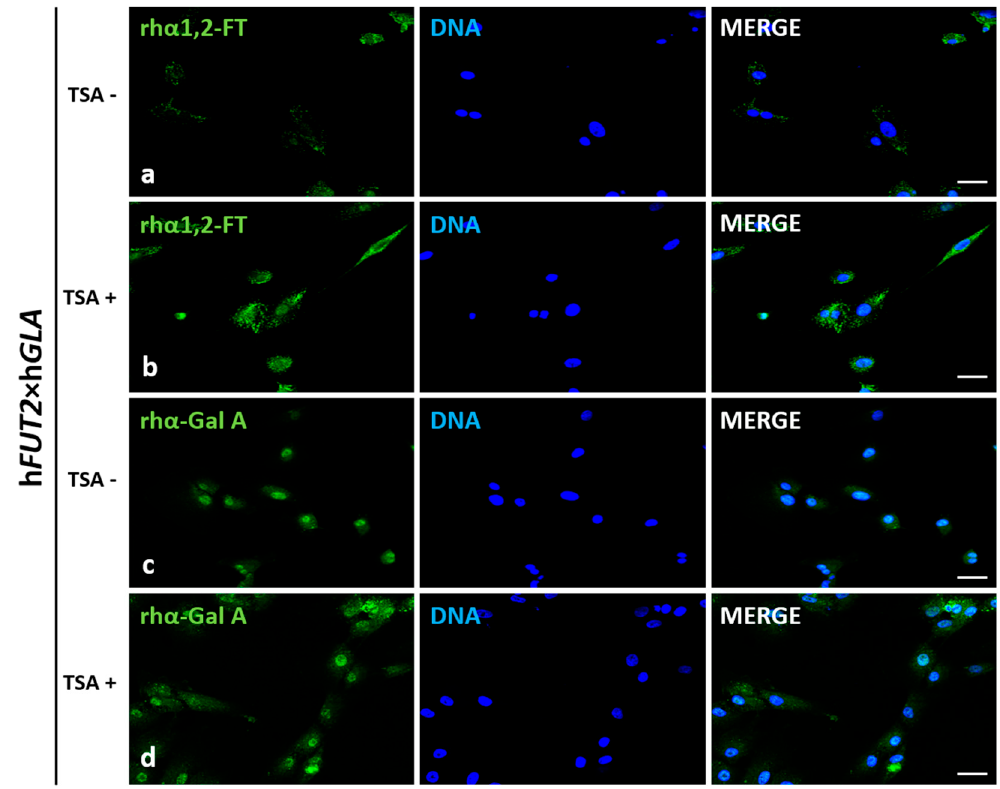
Figure 2. Immunofluorescence analysis of in vitro-cultured porcine ACFCs treated (TSA + ) ( b , d ) and not treated with trichostatin A (TSA − ) ( a , c ). Representative microphotographs of immunofluorescence localization of recombinant human α 1,2-fucosyltransferase (rh α 1,2-FT; a , b ) and α -galactosidase A (rh α -Gal A; c , d ) in ACFCs derived from double-transgenic pigs (h FUT2 ×h GLA ). Immunofluorescent staining with Alexa Fluor 488-labelled secondary antibodies (green fluorescence) and 4 ′ ,6-diamidino-2-phenylindole (DAPI)-mediated counterstaining of cell nuclei (blue fluorescence). Scale bars represent 100 μ m. Immunoreaction was performed on in vitro cultured porcine ACFCs from at least three pigs of each experimental group. The immunofluorescence signal stemming from rh α 1,2-FT was distributed in the perinuclear region of all the analyzed cells from each variant. The recombinant human α -galactosidase A was located homogeneously in whole cytoplasm of all the analyzed cells. The TSA + cells exhibited a more intense signal for both rh α 1,2-FT and rh α -Gal A proteins ( b , d ) than their TSA − counterparts ( a , c ) .